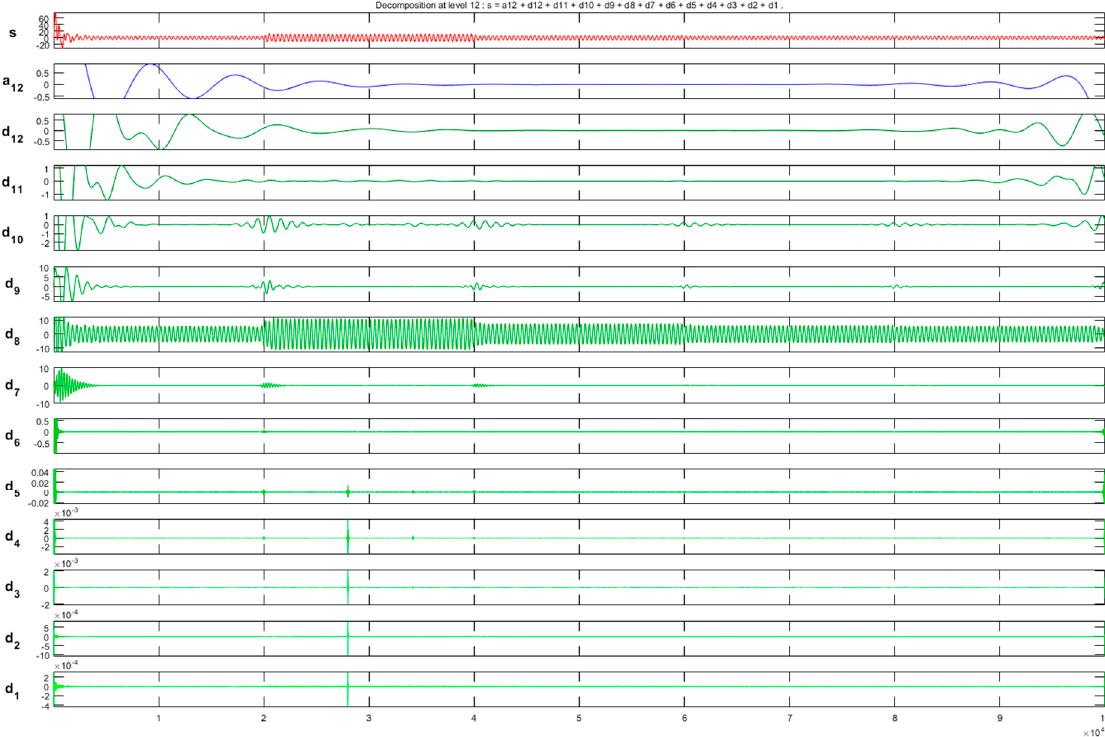
Figure 5. Reconstructed signals of Current A using DWT during unrecognizable faulty operation.